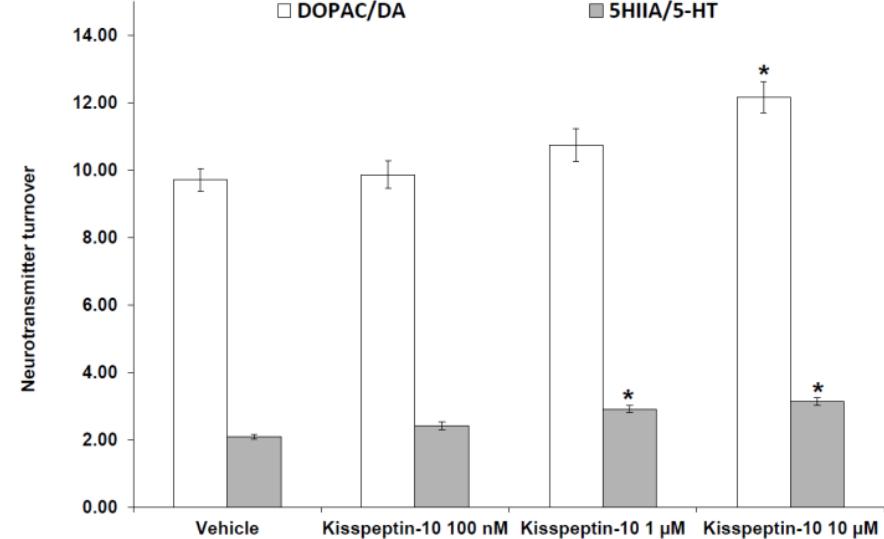
Figure 4. Effect of kisspeptin-10 (100 nM–10 μM) treatment on extracellular dihydroxyphenylacetic acid (DOPAC)/dopamine (DA) and 5-hydroxyindoleacetic acid (5-HIIA)/serotonin (5-HT) ratios as determined by HPLC in rat hypothalamic (Hypo-E22) cell line ( n = 5 individual culture flasks for each condition). Compared to control, kisspeptin-10 treatment significantly increased extracellular DOPAC/DA and 5-HIIA/5-HT ratios (ANOVA, p < 0.01; post-hoc, * p < 0.05 vs. control).